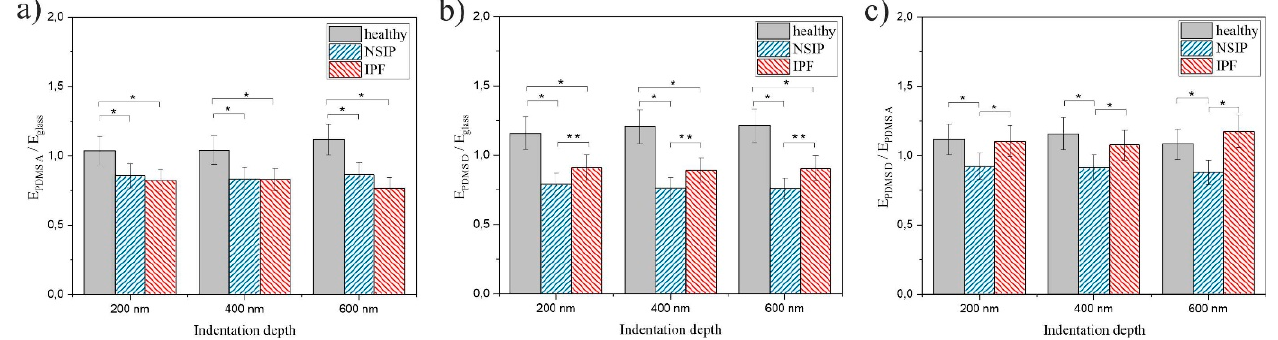
Figure 7. The ratio between Young moduli E PDMS A /E glass ( a ), E PDMS D /E glass ( b ), and E PDMS D /E PDMS A ( c ) calculated for healthy (gray), NSIP- (blue), and IPF-derived (red) fibroblasts cultured on PMDS A, PDMS D, and glass (control). Statistical significance was achieved for p < 0.01 (*) or p < 0.05 (**).